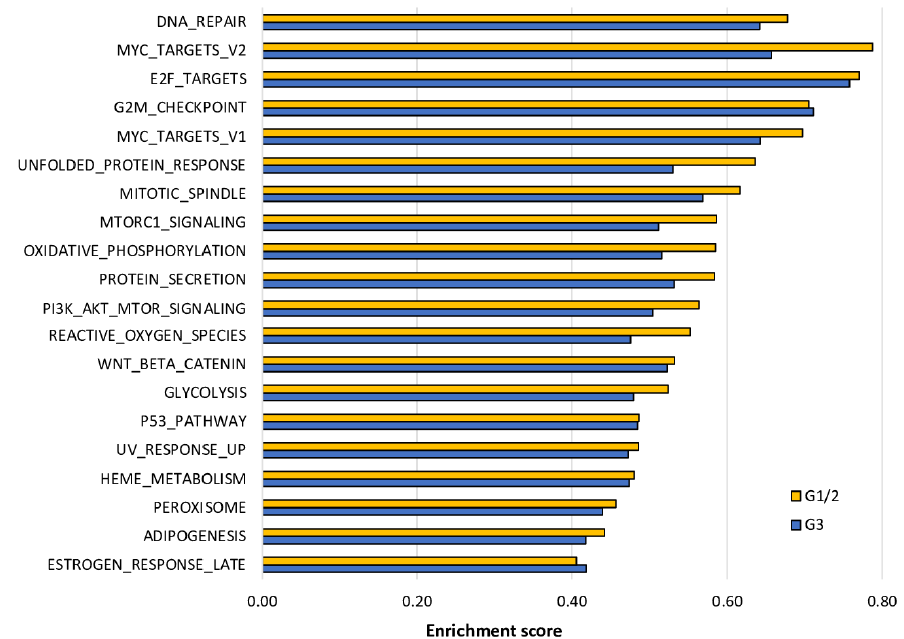
Figure 6. Gene set enrichment analysis (GSEA) of the Hallmark gene sets with significant enrichment due to DNA repair high HCC. Gene sets were listed by the order of high to low enrichment score for the Hallmark gene sets that were statistically significant (false discovery rate (FDR) < 0.25, as recommended by the GSEA software) in grade 1/2. Yellow bars represent the enrichment score of grade 1/2 and the blue bars that of grade